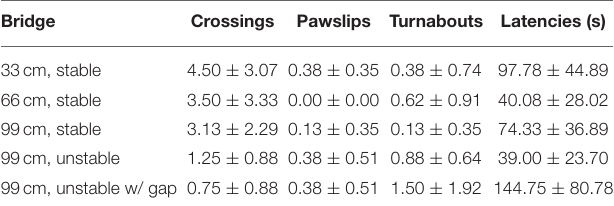
TABLE 2 | Mean ( ± SEM) number of the performances on the different bridges in Group 2 (WT rats grown up with WT rats). Bridge Crossings Pawslips Turnabouts Latencies (s)